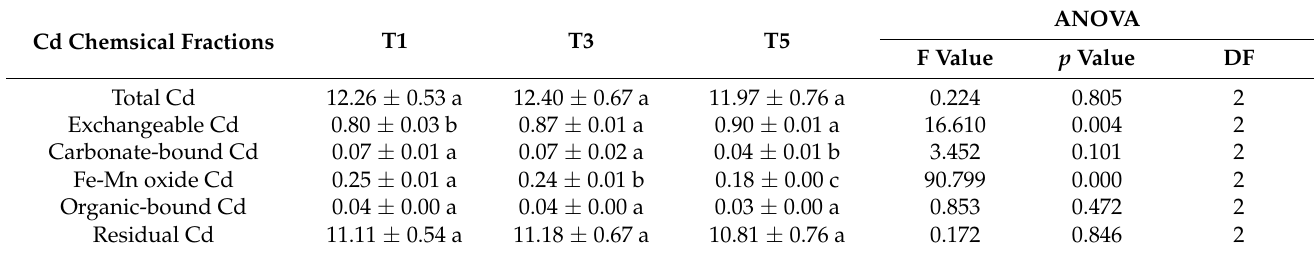
Table 1. Cd speciation (mg kg − 1 ) in the rhizosphere of C. grandiflora supplemented with 0 (T1), 2 (T3), and 8 (T5) g kg − 1 gamma-aminobutyric acid (GABA).